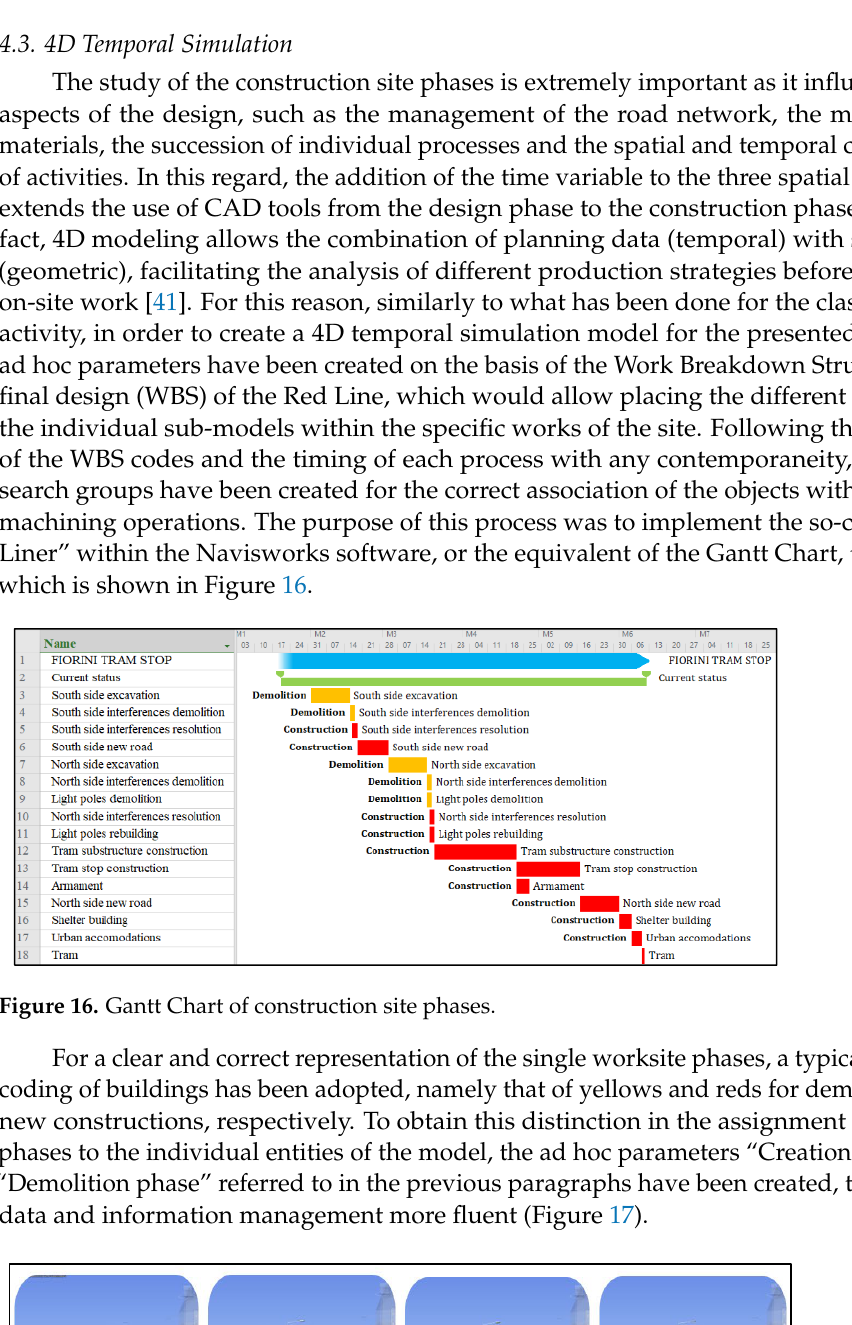
Figure 15. Activity workflow for an effective Clash Detection.